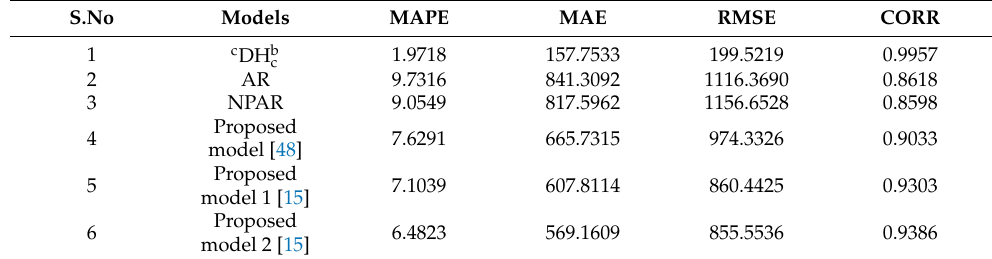
Table 6. Pakistan’s electricity consumption (kWh): mean performance measures of the proposed versus the